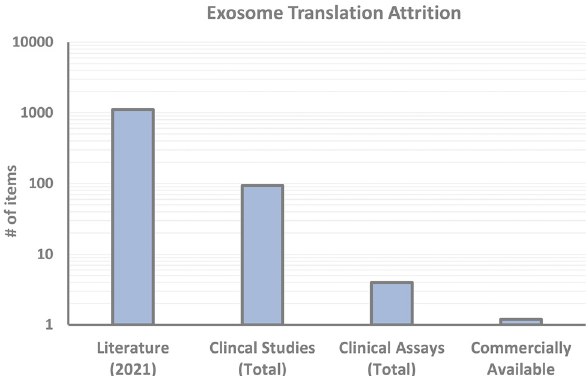
Figure 4: There is a significant attrition on the path from academic research through translation into clinically validated